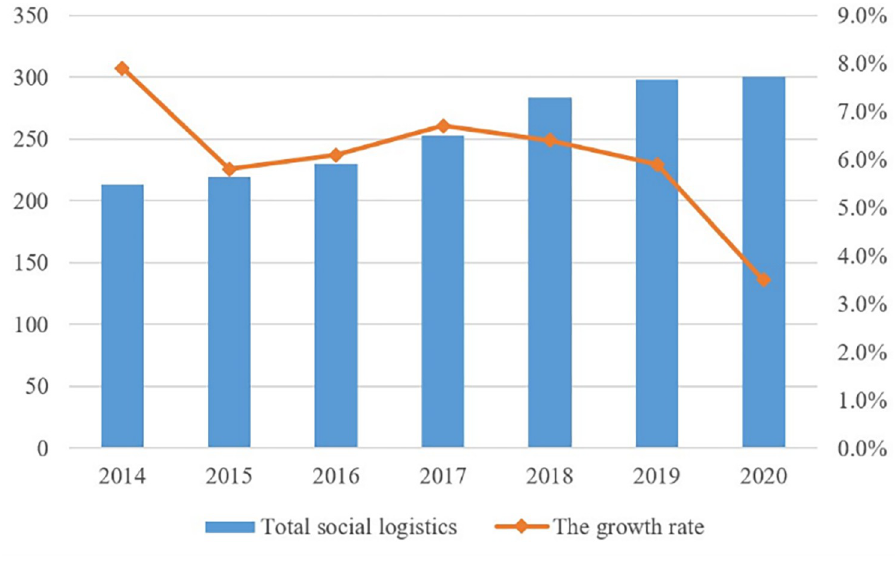
Fig 2. Trend of China’s total social